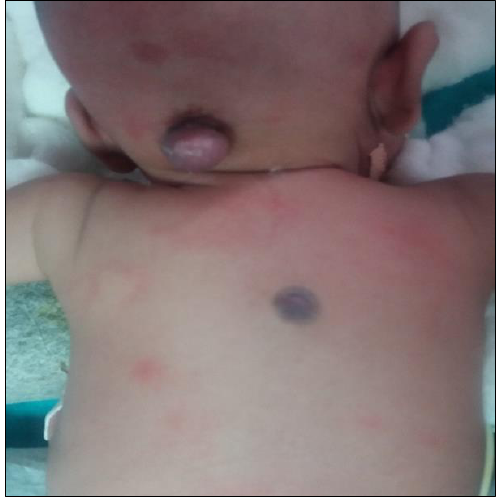
Figure 2: Occipital encephalocele and thoracic vascular lesion with underlying MMC.